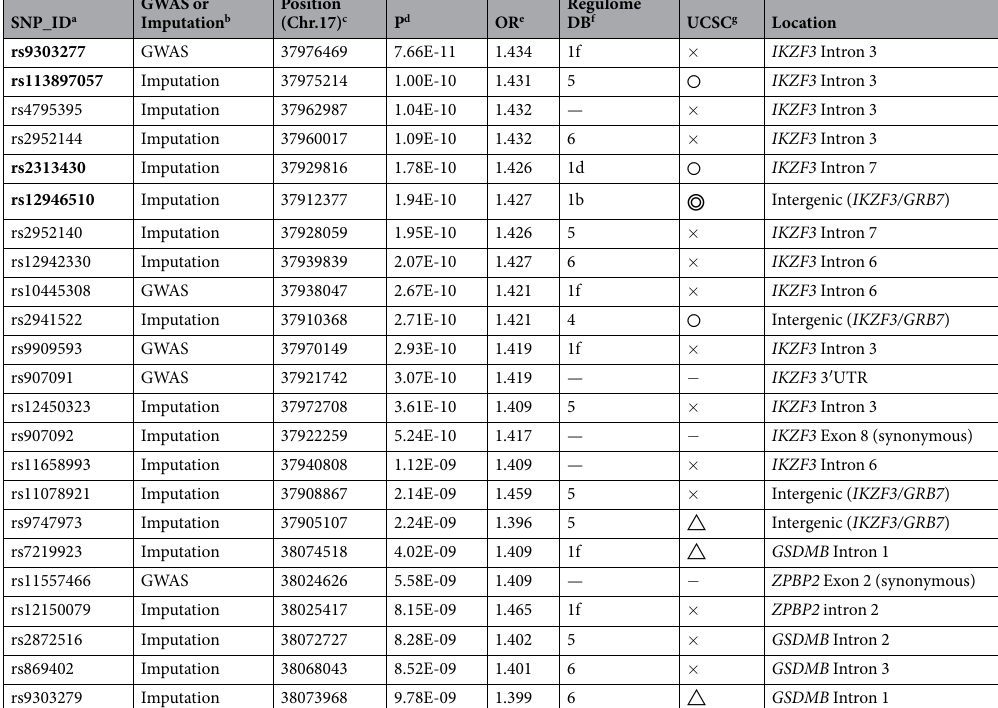
Table 1. High-density association mapping of SNPs located in chr.17q12-21 that are associated with susceptibility to PBC in the Japanese population. a SNPs shown in bold were the final candidate for primary functional variants. b Genotyped by our previous GWAS (ref. 16) or the imputed genotypes by the high-density association mapping in the present study. c Position of the SNPs in hg19. d P values calculated for the allelic model using Pearson’s Chi-square test. e Odds ratio (OR) of the minor allele as calculated from the two-by-two allele frequency table. f Functinoal prediction scores of each SNPs by RegulomeDB database. g Probability of the functional damages checked by UCSC genome